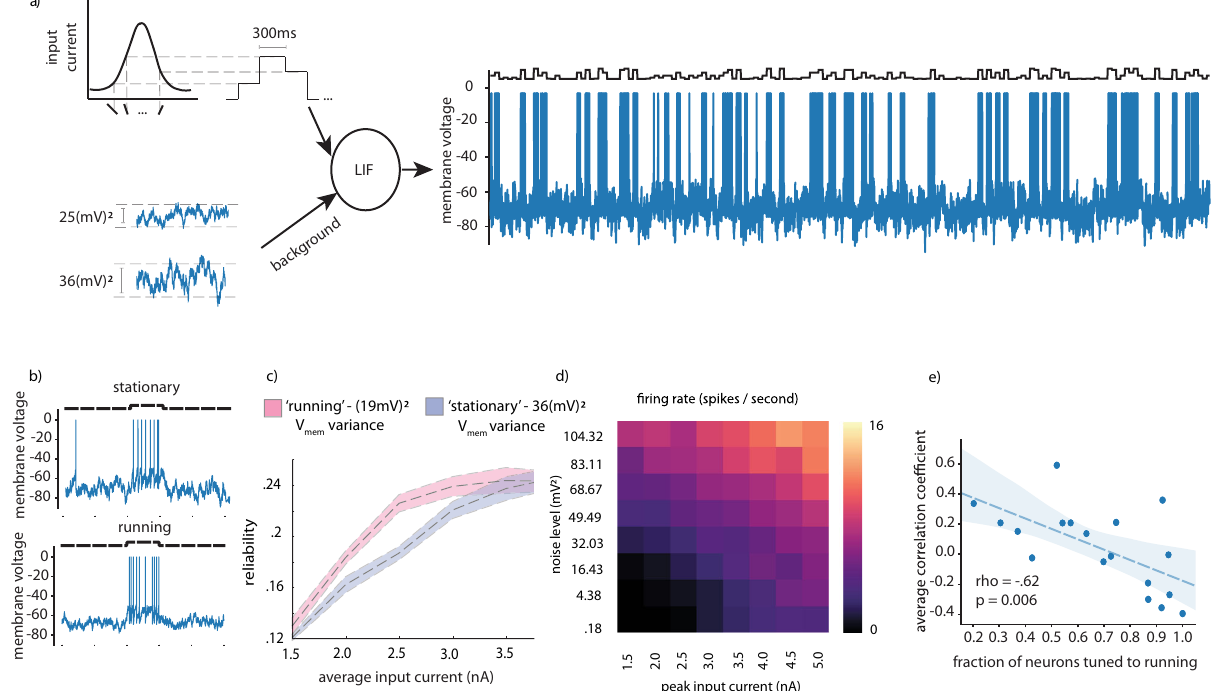
Fig. 4 LIF model demonstrating how membrane voltage noise can impact neural reliability. a Schematic explaining LIF simulation with additive Gaussian noise corresponding to membrane voltage measured during stationary (top) and running (bottom) epochs b Firing rate versus noise level and peak input current. c Example of LIF simulations corresponding to running and stationary periods with current injection . d Reliability versus input current for running and stationary membrane voltage noise levels. Error envelope standard deviation over 10 independent runs of model simulation. e Correlation between fraction of neurons tuned to running in each region and cre-line and the average correlation coef fi cient to running measured in that region and cre-line. Wald test with t distribution statistic, against the null hypothesis the slope is zero, two-sided. 18 data points are presented, one for each region and cre-line analyzed. Underlying cell numbers as in Supplementary Fig. 1h,